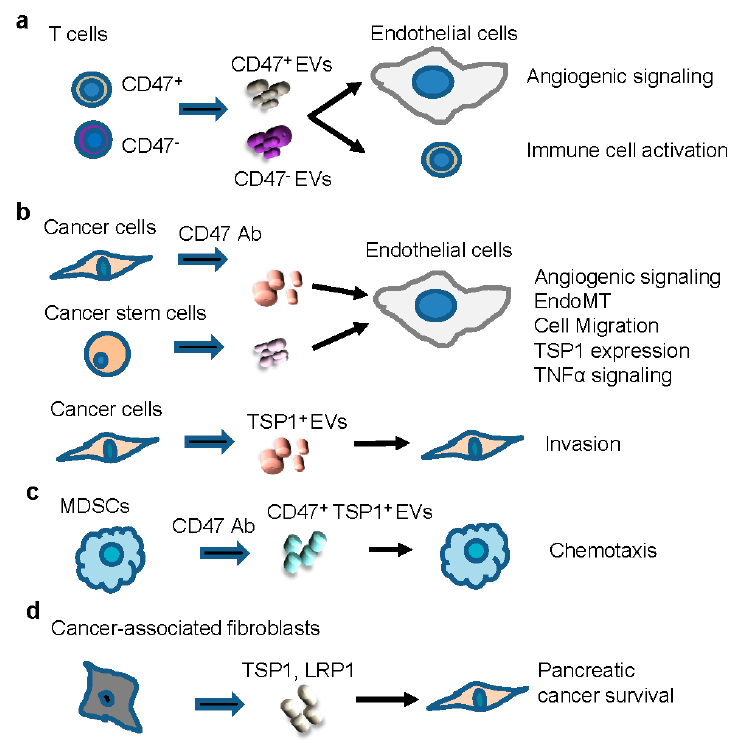
Figure 5. Roles of TSP1 and CD47 in the intercellular communication mediated by EVs in the tumor microenvironment. EVs derived from T cells ( a ) modulate angiogenic signaling in endothelial cells and activate other T cells in a CD47-dependent manner. EVs produced by cancer cells and cancer stem cells ( b ) have TSP1- and CD47-dependent effects on endothelial cells and other tumor cells that CD47 antibodies can modulate. EVs enriched with TSP1 from myeloid-derived suppressor cells (MDSCs, ( c )) stimulate chemotaxis, blocked by a CD47 antibody. EVs produced by cancer-associated fibroblasts ( d ) containing TSP1 associated with LRP1 are circulating poor survival markers.